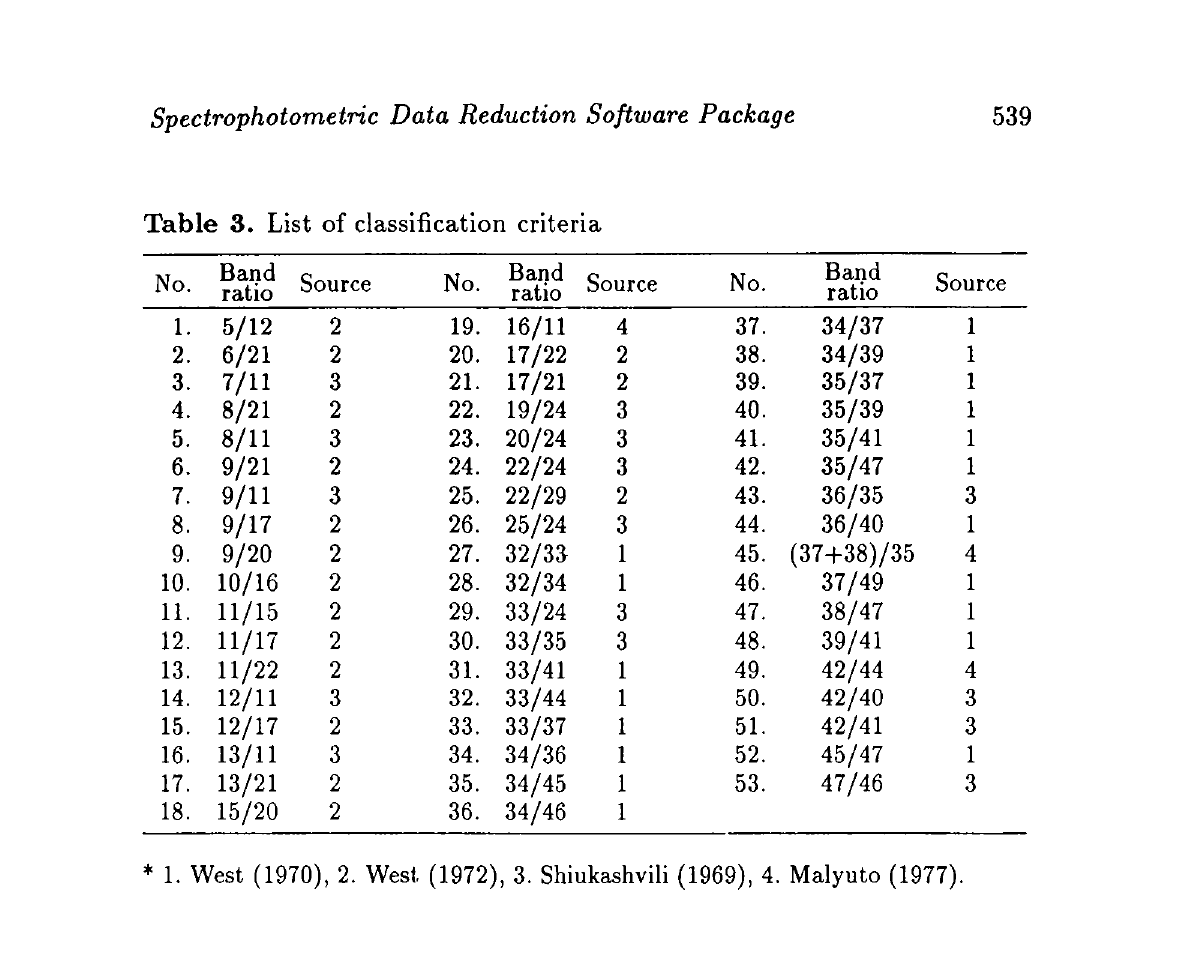
Table 3. List of classification